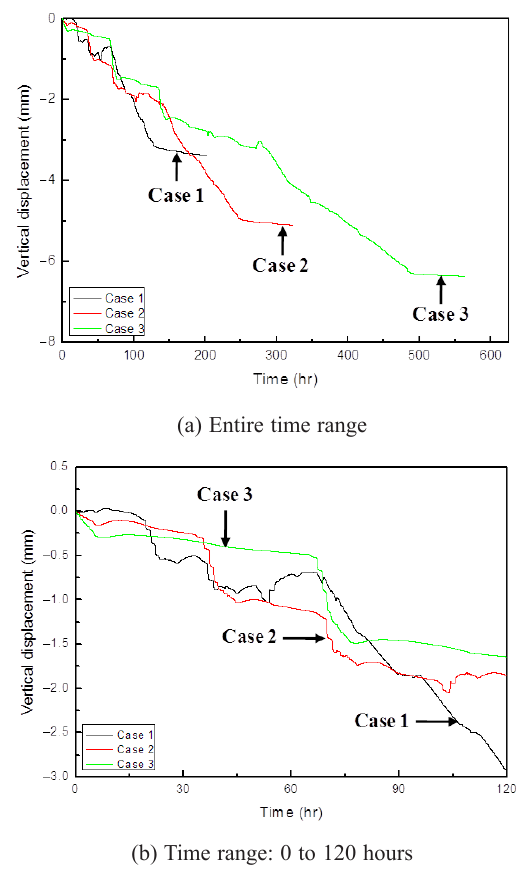
Fig. 16. Time histories of vertical displacement at reservoir side of levee during water-level-raising process on each case (after 62.5 hours, at Node 1127)